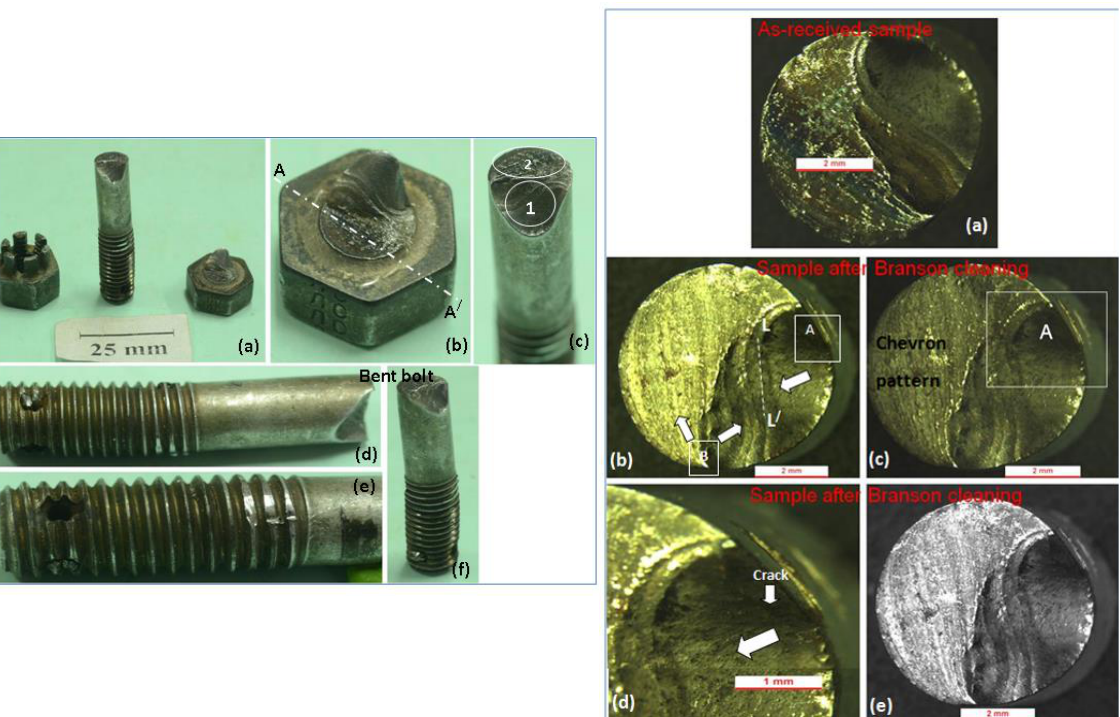
Fig.1: Photographs of as-received failed components. Figure 2: Stereo microscopic images of failed bolt